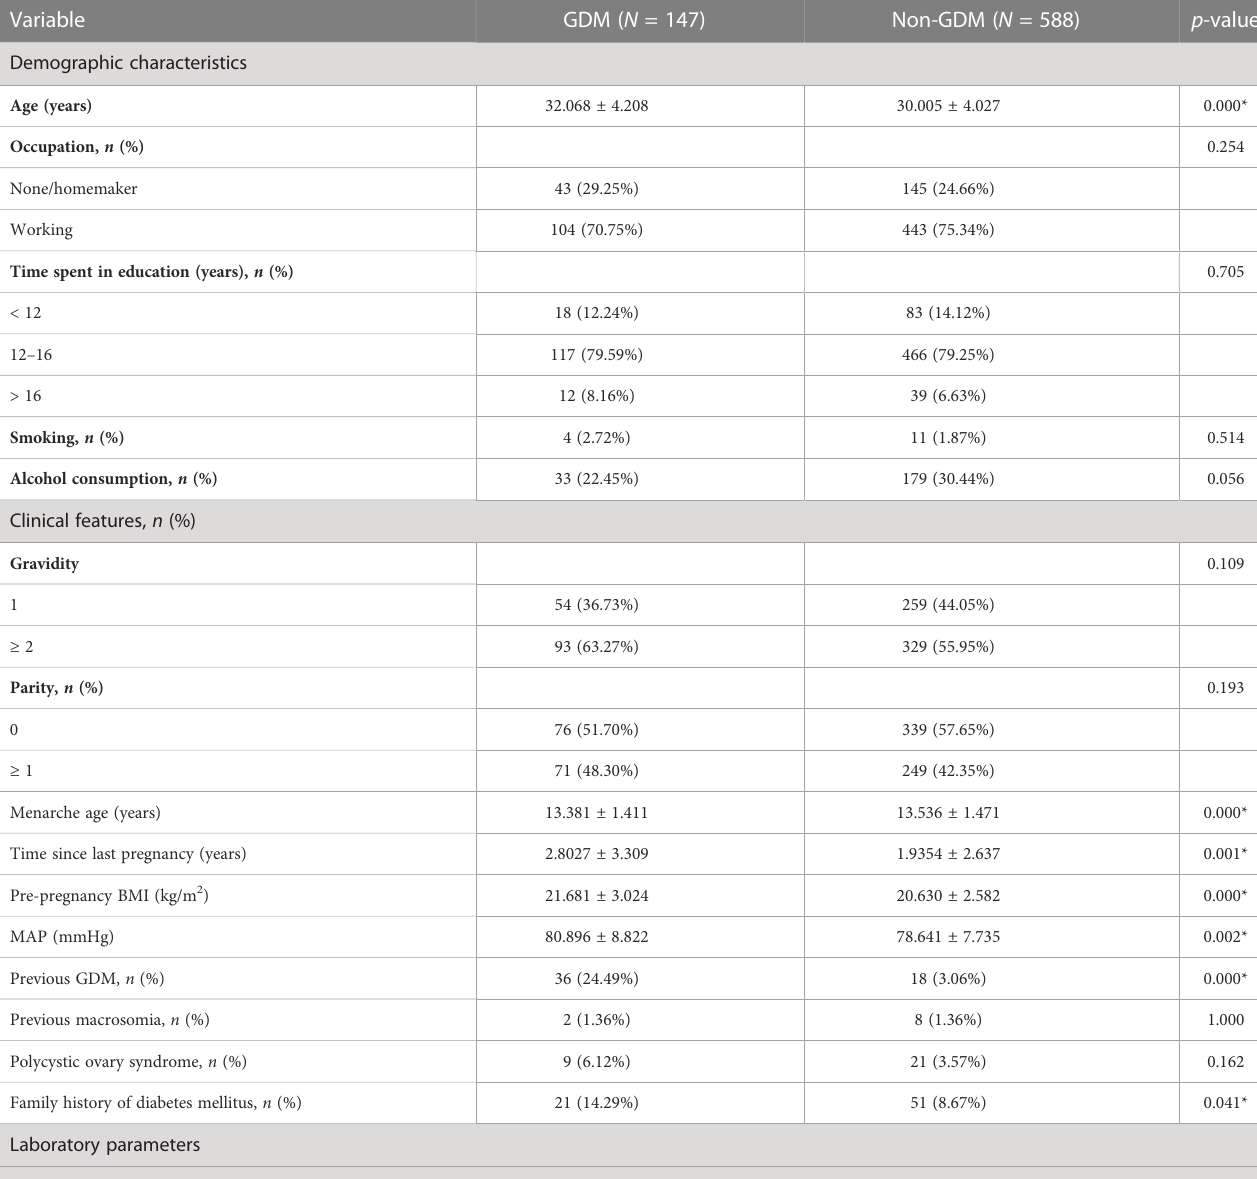
TABLE 1 Demographic characteristics, clinical features, and laboratory parameters of participants with GDM and non-GDM control participants in the training set. Variable GDM ( N =